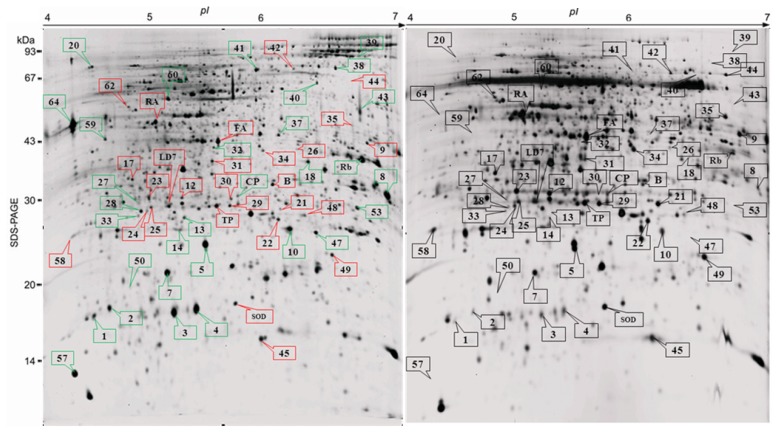
2-D gel electrophoresis of IR64 leaf sheath proteins following brown planthopper (N. lugens) infestation (left panel) and control (right panel) condition. Total plant proteins extracted using TCA-Acetone method were separated on 15% SDS PAGE using non linear (NL) 18-cm IPG strips. The gels were stained with silver nitrate for protein detection. The red boxes represent down regulated proteins whereas green boxes represent up regulated proteins after BPH infestation.